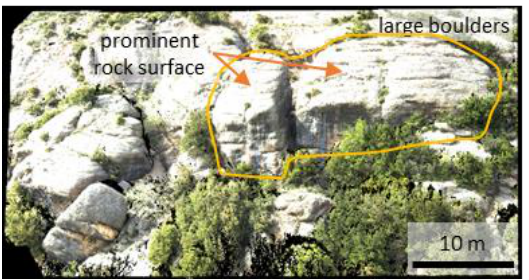
Figure 3. RGB-colored point cloud of the subsample for